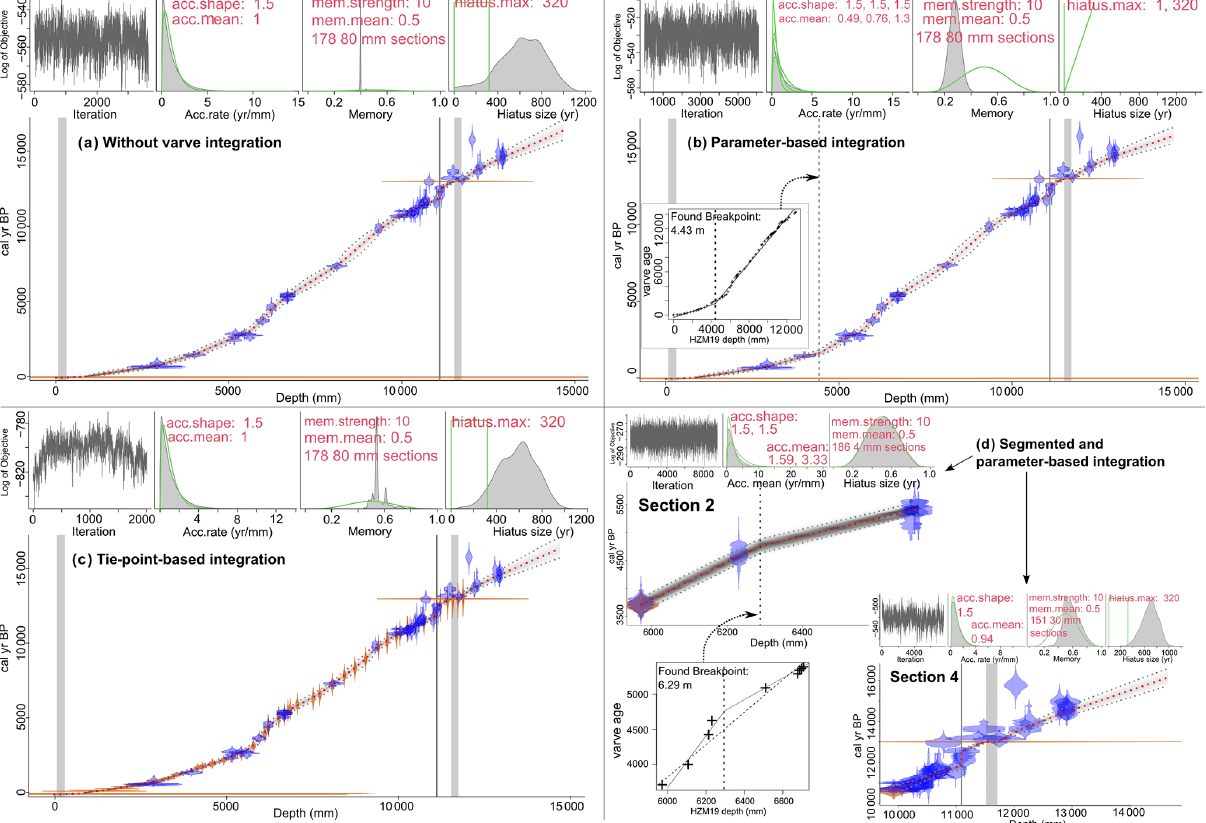
Figure 5. Bacon output for Models A (a) , B (b) , C (c) , and D (d) (sections 2 and 4). In each age-depth model plot (a–d) : MCMC iterations, prior (green) and posterior (grey) for accumulation rate distribution, memory, and hiatus with defined settings in red. The main graph in each age–depth model plot shows the model with calibrated radiocarbon date probabilities (blue), tie points with normal distribution (orange), and the posterior age–depth model with mean (dotted red line) and 95% confidence intervals (dotted grey line). The vertical grey lines (from left to right) in the main graphs show the slump event, defined hiatus, and Laacher See Tephra. Two boundaries indicating major changes in accumulation rate are provided as vertical dotted